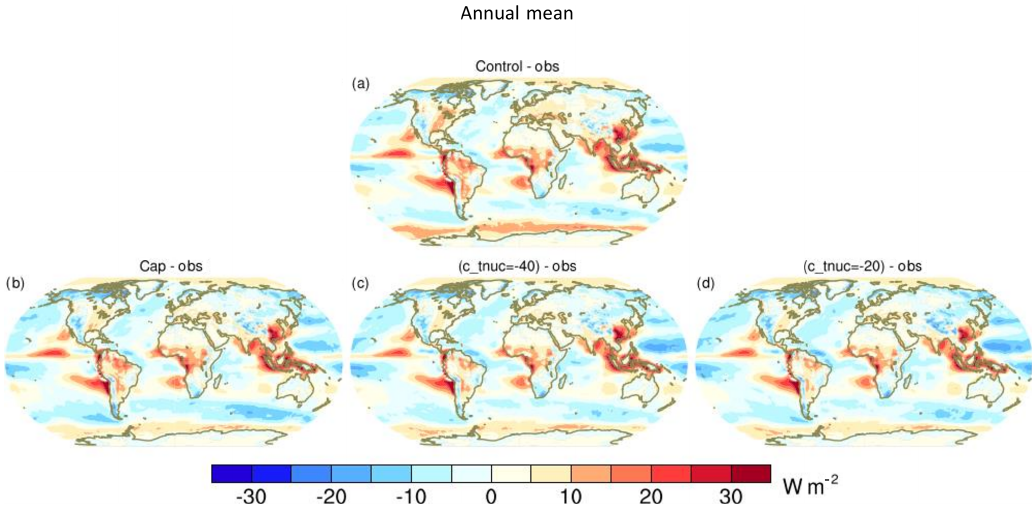
Figure 7. Spatial distributions of annual-mean SW CRE anomaly at TOA in different model simulations with respect to the CERES TOA data. Panel (a) indicates control minus obs; (b) cap minus obs, (c) ( c_tnuc=-40 ) minus obs; (d) ( c_tnuc=-20 ) minus obs. Model data are calculated from daily-mean output over 22 years. Observational (CERES EBAF TOA) data consist of monthly-mean values covering the period